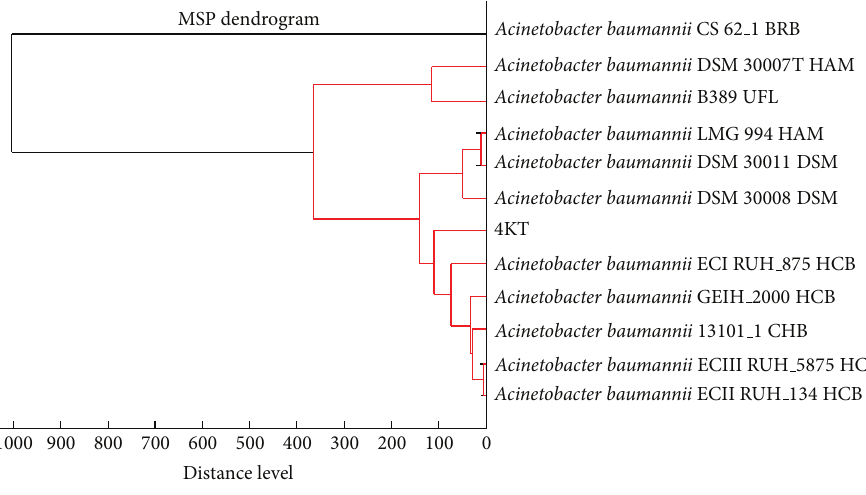
Figure 3: Score-oriented dendrogram of A. baumannii clinical isolate 4KT (labeled as 4KT in the